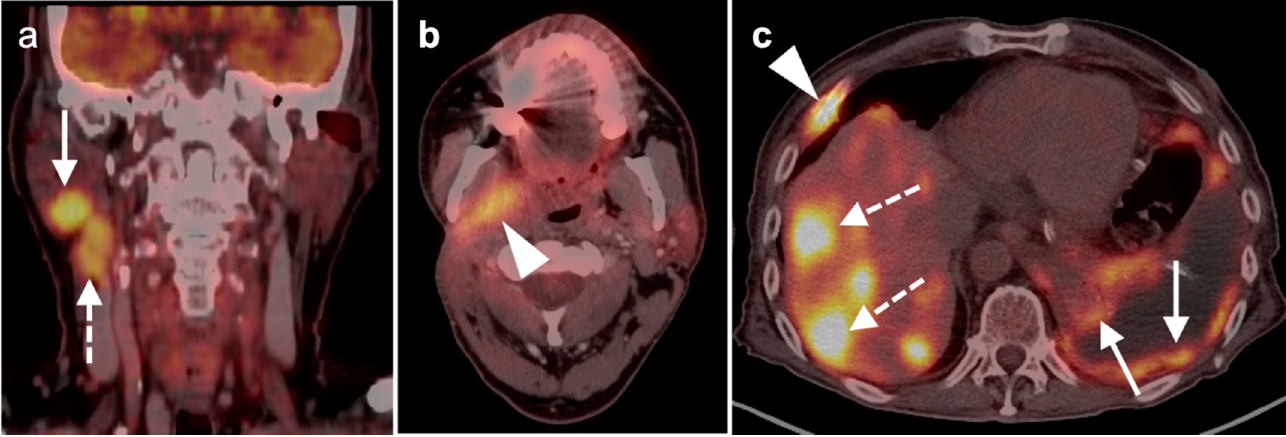
Figure 28. Mucoepidermoid carcinoma (MEC). ( a ) Initial coronal FDG PET-CT image shows a hypermetabolic tumor in the right parotid gland (white arrow) with spread to an adjacent cervical lymph node (white dashed arrow). ( b ) Seven years after initial right neck dissection, there is recur ‐ rence in the deep lobe of the right parotid (white arrowhead). ( c ) Also 7 years after initial treatment, there are widespread systemic metastases to the bones (white arrowhead), liver (white dashed ar ‐ row) and left pleura (white arrow).